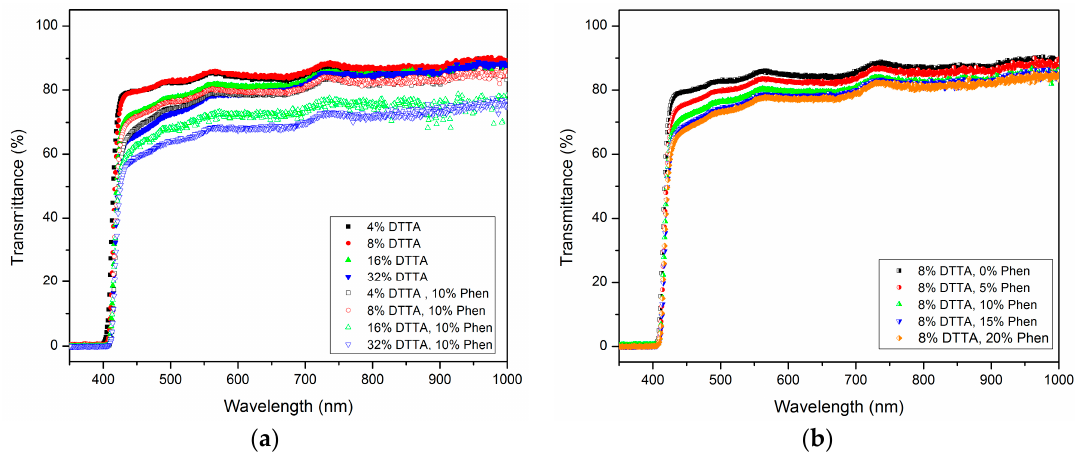
Figure 7. Optical transmittance of DTTA-containing mixtures: ( a ) Influence of DTTA content without and with 10% phenanthrene; ( b ) Influence of phenanthrene content at constant DTTA